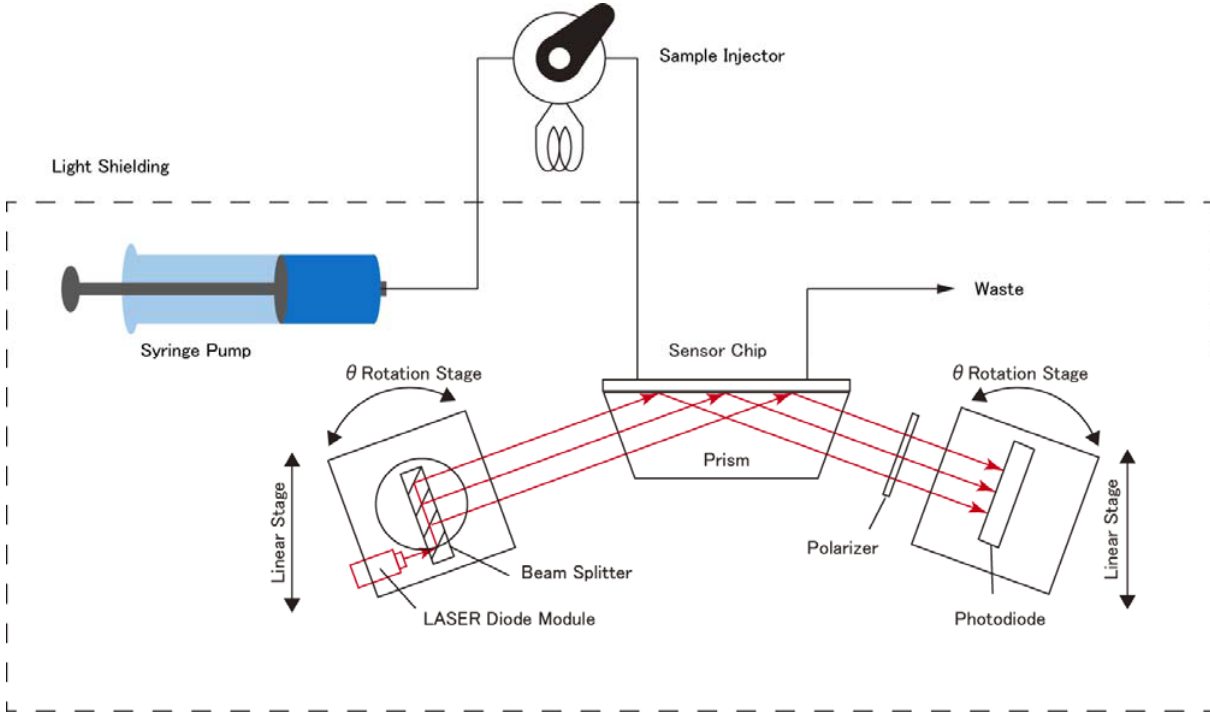
Figure 6. Flow analysis system for 2D SPR